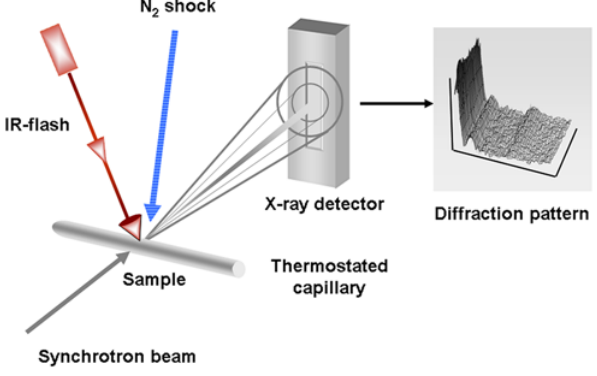
Figure 1. Sketch of the experimental setup. The experimental arrangement for time-resolved X-ray measurements at the Austrian SAXS–beamline at the ELETTRA synchrotron light source is shown. For T-jump experiments, an erbium laser beam (IR), wavelength l =1.5 m m, was directed via a prism onto the sample capillary which was thermostated with a Peltier unit. Laser pulse energy was 2 J within 2 ms resulting in an average T-jump amplitude of 10–12 u C. The exposure time was 10 ms per frame. For T-drop experiments, the empty X-ray capillary was pre-cooled in a stream of nitrogen adjusted to 2 20 u C. LDL samples, preheated to approx.10 u C above the melting transition, were injected by a motor-driven syringe. A drop in temperature of about 20 u C could be induced in about 3–4 s. The exposure time was 250 ms per frame.